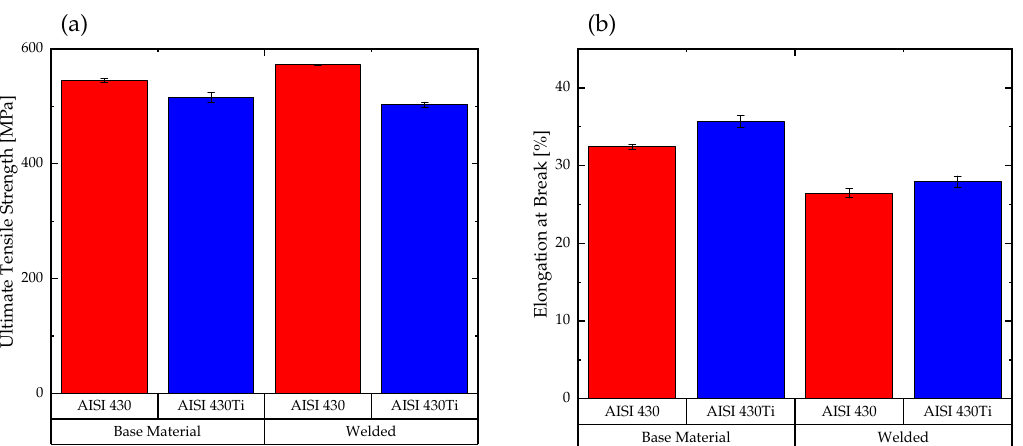
Figure 11. Comparison of ( a ) ultimate tensile strength and ( b ) elongation at break for both materials in as-received and welded condition. Mean values and SEM for welded condition calculated from the results obtained for different energy inputs.